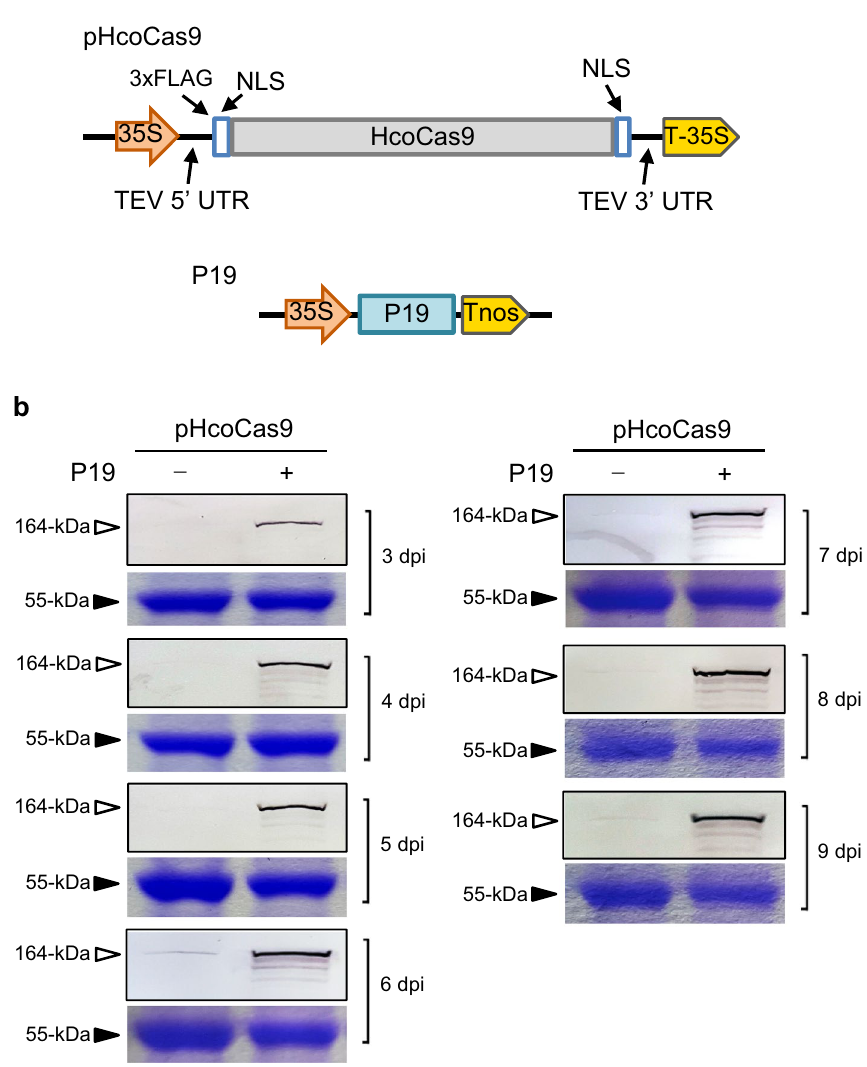
Figure 1. pHcoCas9-induced expression upon supplying the RNA silencing suppressor P19. ( a ) The binary vector construct of pHcoCas9 used to deliver the Cas9 endonuclease and the P19 construct used to deliver P19 suppressor protein. ( b ) pHcoCas9-delivered Cas9 protein expression co-infiltrated with and without a plasmid expressing P19 in N. benthamiana from 3 to 9 days post infiltration (dpi). The top panels for each day are western blots used to detect Cas9 protein (164-kDa). The bottom panels are protein gels stained with Coomassie using Rubisco (55-kDa) as a loading